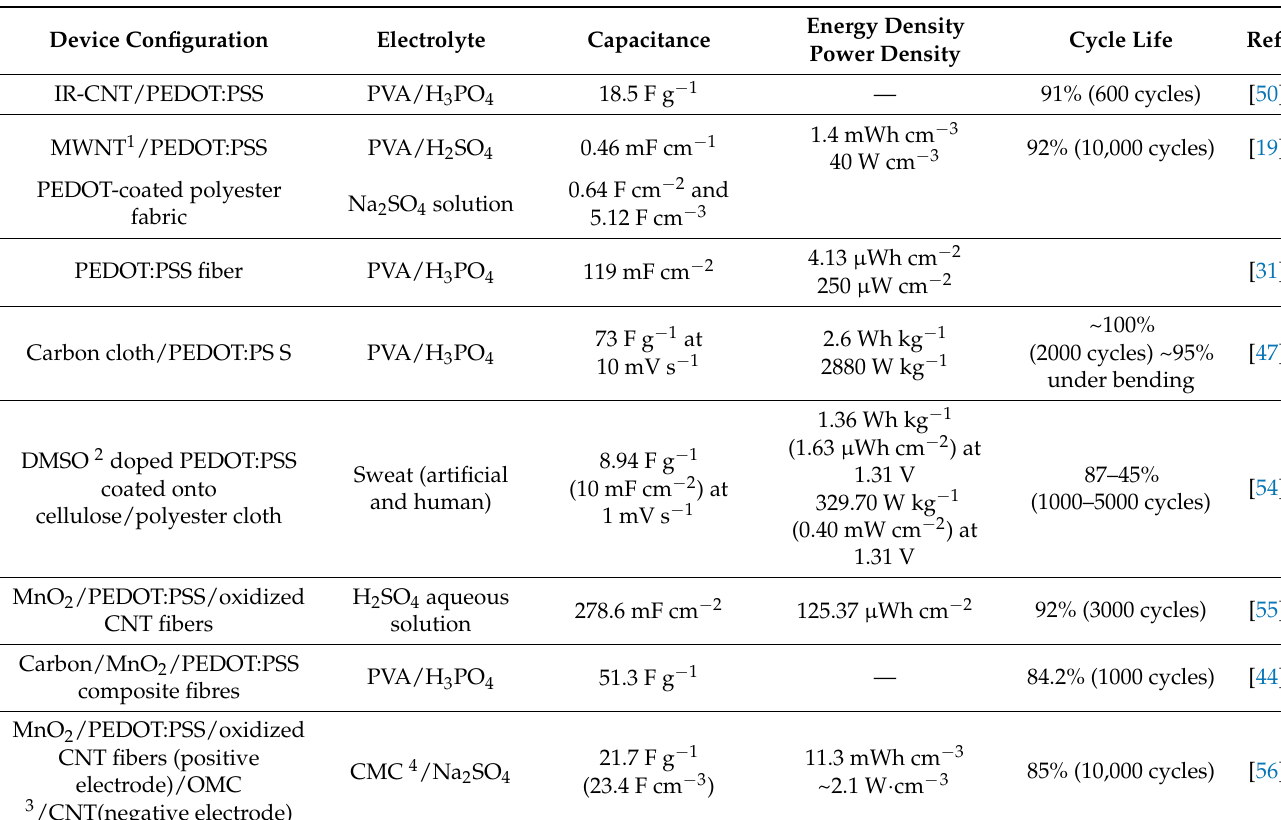
Table 1. Summary performance of previously reported similar fiber supercapacitors